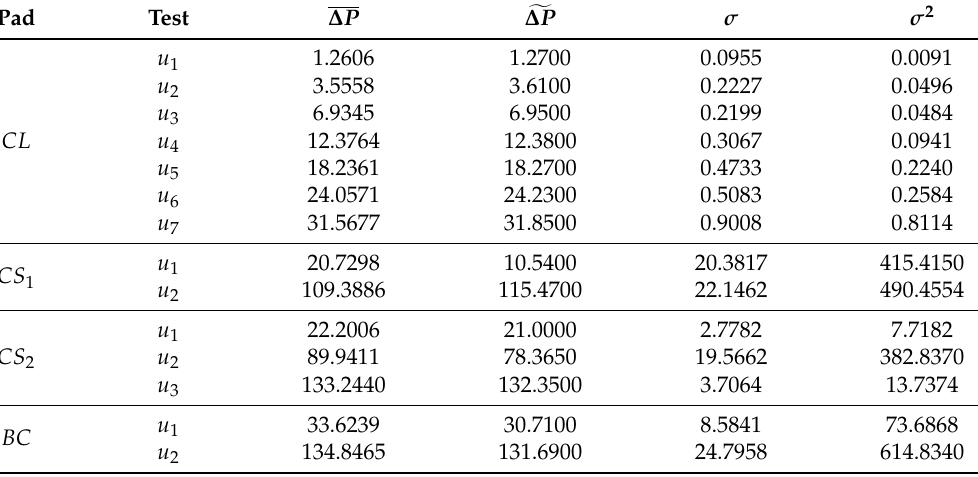
Table 10. Statistics of pressure drop across the cooling pad ( ∆ P ) for the wind tunnel tests. ∆ P is the mean [Pa], (cid:102) ∆ P is the median [Pa], σ is the standard deviation [Pa] and σ 2 is the variance [Pa 2